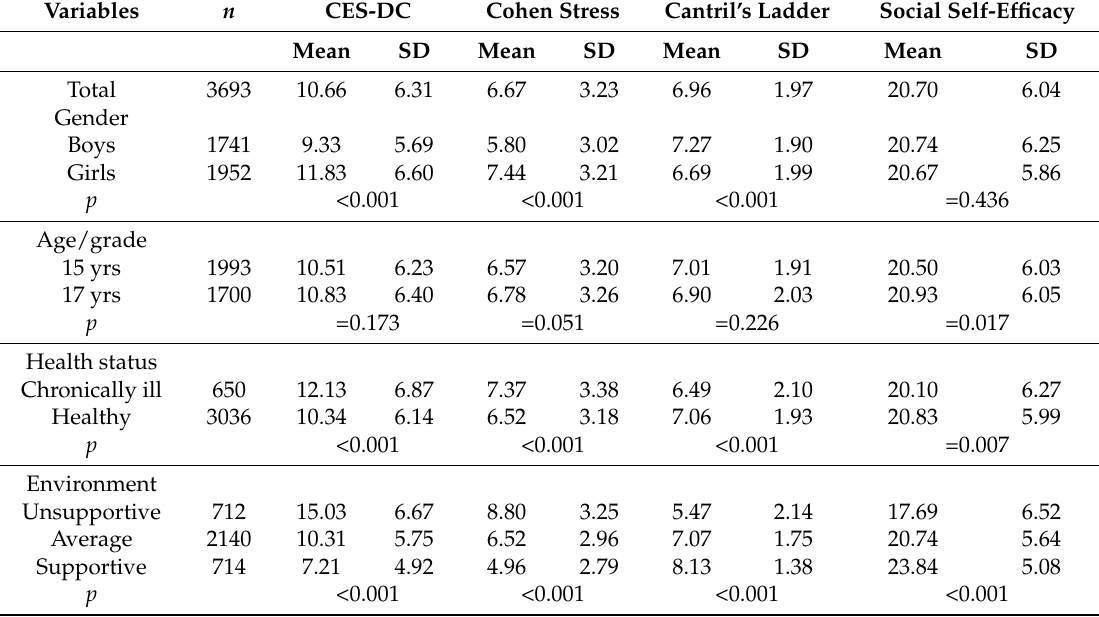
Table 2. Mental well-being of adolescents according to basic characteristics.